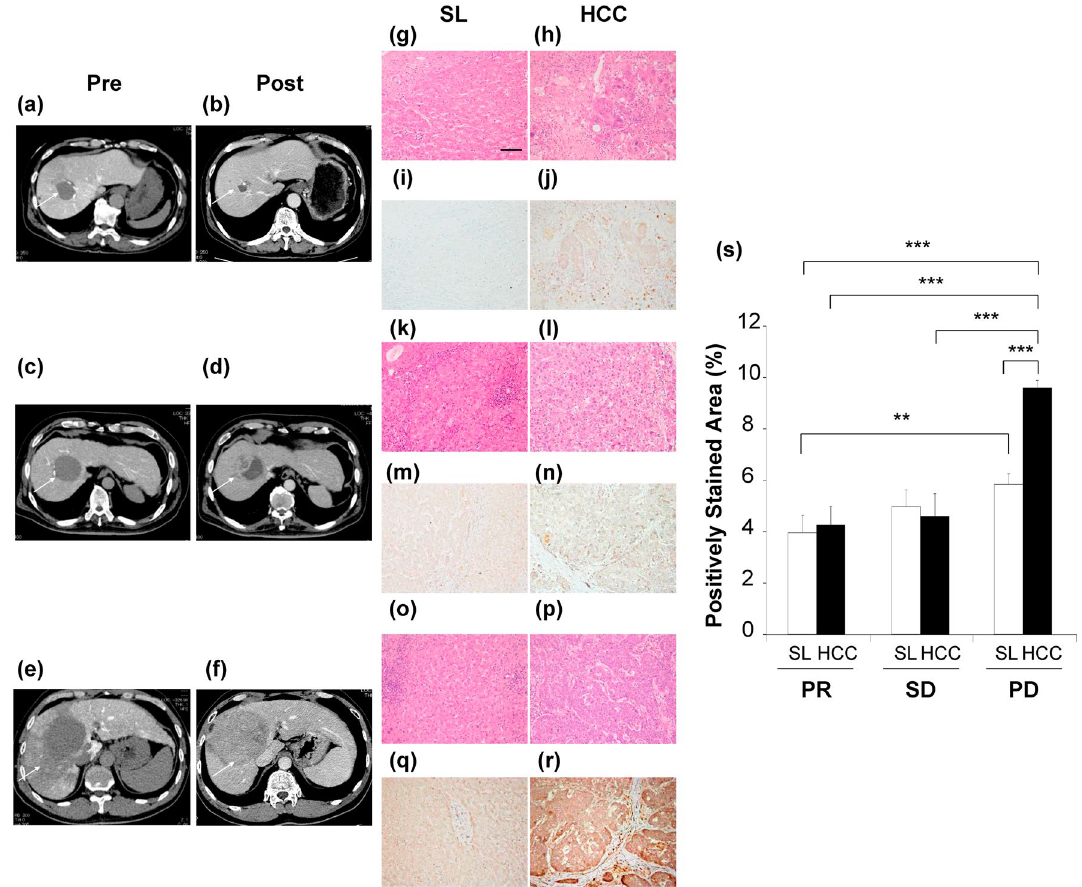
Figure 5. The APM2 expression in the liver tissue and chemosensitivity to CDDP. The representative computed tomography images before and after the transcatheter arterial infusion of cisplatin (CDDP) to the hepatocellular carcinoma (HCC) resulted in the partial response (PR), stable disease (SD) and progressive disease (PD). White arrows indicate the tumors. ( a , b ) PR case, ( c , d ) SD case, ( e , f ) PD case. White arrows indicate the tumor. ( g – r ) Representative histological analyses. Hematoxylin and eosin staining of surrounding liver tissue (SL) and HCC in PR case ( g , h ), SD cases ( k , l ) and PD case ( o , p ). Immunohistochemical staining of APM2 of SL and HCC in PR case ( i , j ), SD cases ( m , n ) and PD case ( q , r ). The scale bar represents 100 µm. ( s ) A quantitative analysis of positively stained area in SL and HCC tissues with APM2. For quantitative measurements, 3 representative images from each patient in 3 groups (PR, n = 4, SD, n = 6, PD, n = 3) were captured at a final magnification of × 200. Quantification was performed measuring the integrated density in pixels using the ImageJ software (version 1.6.0_20, National Institutes of Health, USA). The APM2 stained/negative control ratio of the integrated density in pixels was calculated as the relative integrated density. The values represent means ± standard deviations. APM2, adipose most abundant 2. ** p < 0.01, *** p < 0.001, One-way analysis of variance followed by Bonferroni’s multiple comparison test. ( t – v ) The ERCC6L expression in the liver tissue and chemosensitivity to CDDP. The representative immunohistochemical staining of ERCC6L in the hepatocellular carcinoma (HCC) showed partial response (PR), stable disease (SD) and progressive disease (PD). ( t ) PR case, ( u ) SD case, ( v ) PD case. The scale bar represents 100 µm. ( w ) A quantitative analysis of positively stained cells with ERCC6L in 3 groups (PR, n = 4, SD, n = 6, PD, n = 3). Quantification was performed measuring the integrated density in pixels using the ImageJ software (version 1.6.0_20, National Institutes of Health, USA). The ERCC6L stained/negative control ratio of the integrated density in pixels was calculated as the relative integrated density. The values represent means ± standard deviations. * p < 0.05, *** p < 0.001, One-way analysis of variance followed by Bonferroni’s multiple comparison